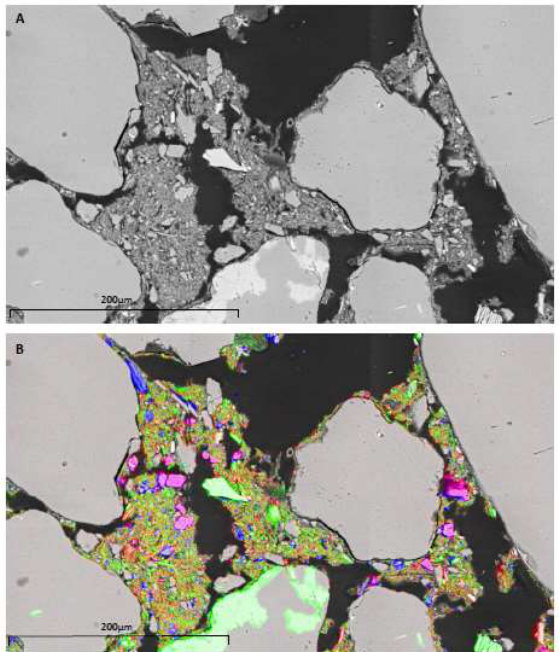
Figure 4. ( A ) Backscatter electron image of River Dee sediments, with detrital material surrounding quartz grain boundaries; ( B ) false colour map indicating the distribution of Mg (red), K (blue) and Ca (green).